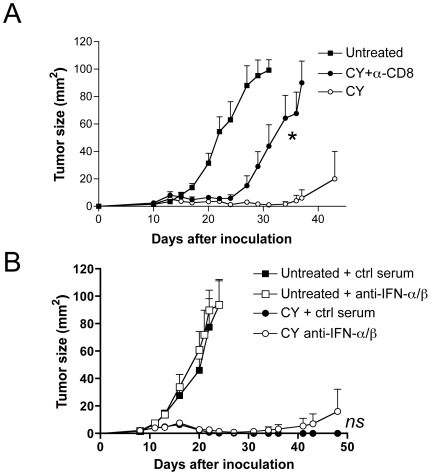
Role of CD8 T cells and type-I IFN in CY-driven anti-tumor efficacy.(A) Anti-tumor responses depend on CD8+ T cells. Tumor-bearing mice were treated with CY at day 10 after tumor inoculation (day 0) and anti-CD8 mAbs (150 µg) were injected at days −1, 0, 2, 4, 6 and 8 with respect to CY treatment. Data shown are mean±SEM (n = 5) from one representative experiment from a total of three experiments with a total of 15 mice. * P<0.05 when CY is compared with CY + anti-CD8. (B) In vivo IFN-α/β neutralization marginally affects tumor growth in CY-treated mice. BALB/c mice bearing AB1-HA tumors were given IFN-α/β blocking antibody on days −1, +2, +4 with respect to CY treatment. Tumors were inoculated at day 0 and were treated with CY at day 9. Data shown are mean±SEM (n = 5) from one experiment. ns = not-significant.